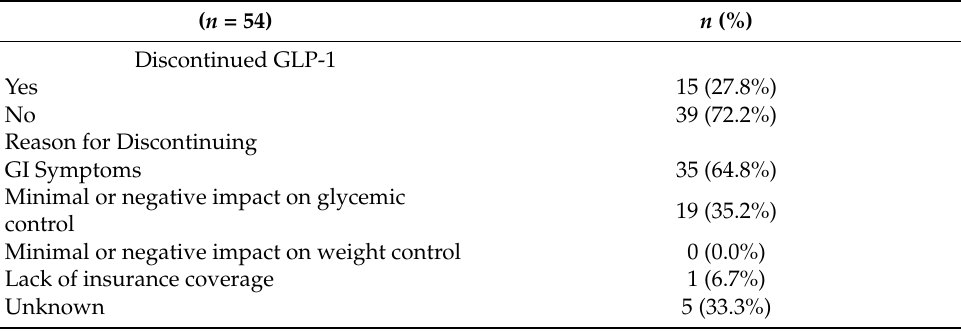
Table 2. Reasons for discontinuing GLP-1.